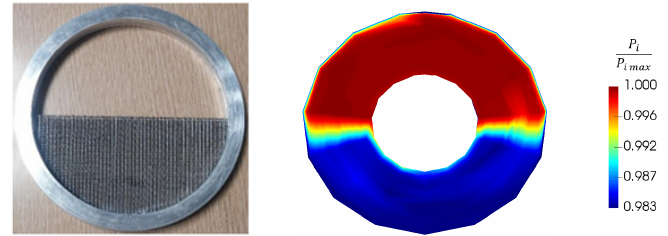
Figure 3. Distortion grid and measured total pressure pattern